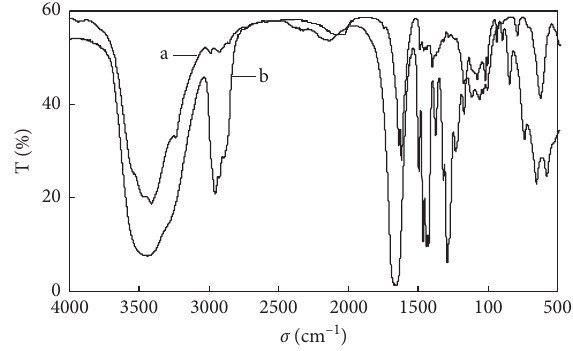
Figure 7: FTIR spectra of (a) cellulose and (b) resin.